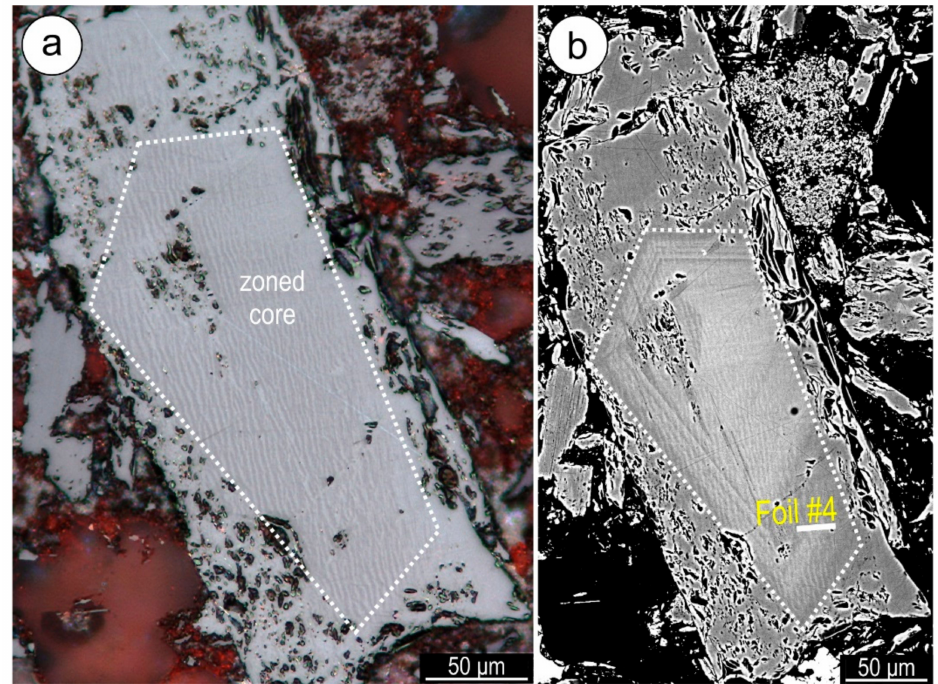
Figure 2. ( a ) Reflected light microphotograph of weave-twinned hematite (grain #2) and ( b ) back scattered electron image of the same grain showing oscillatory zonation patterns. Note the two textures overlap with one another within the grain core (dashed line). Location of extracted foil (Foil #4) is marked on ( b ). Obtained foil shown in Supplementary Material Figure